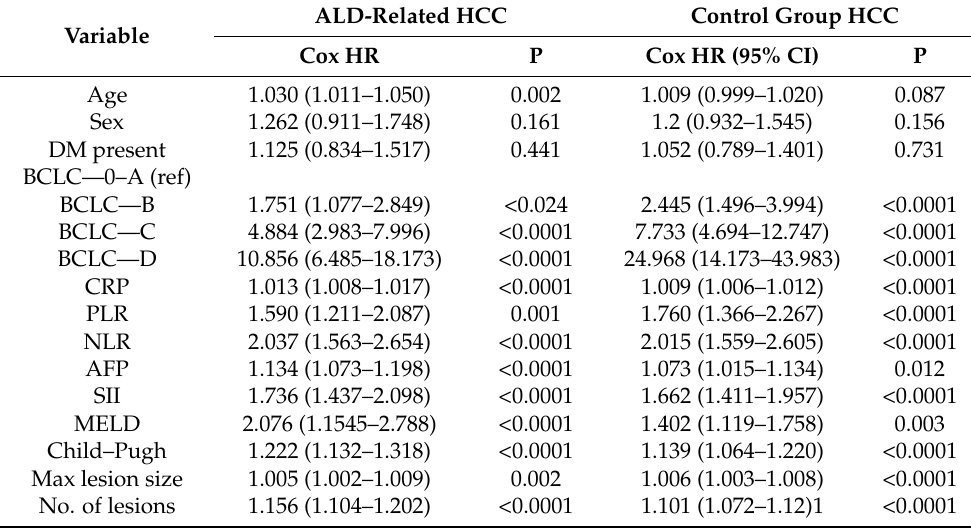
Table 5. Univariate logistic regression analysis of variables associated with survival.